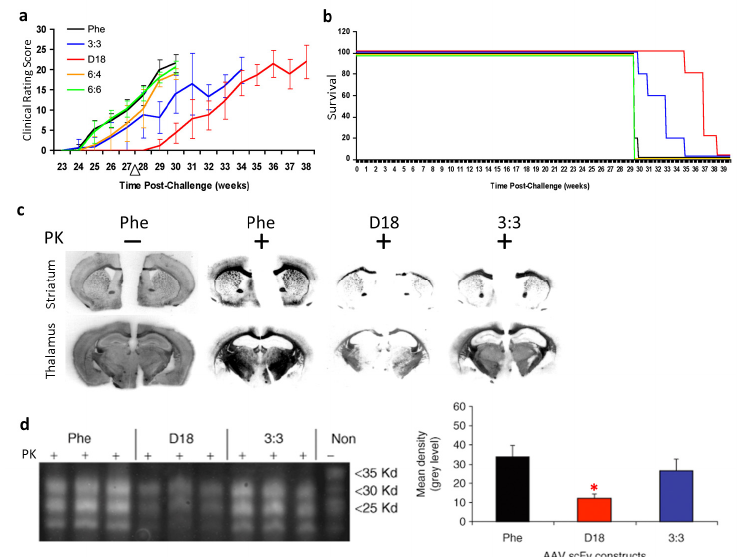
Figure 3. Outcomes of recombinant adeno-associated virus (rAAV) delivered single-chain fragment variable (scFv) therapy for prion disease in transmissible spongiform encephalopathies (TSE) mouse model. ( a ) Clinical rating data show that the disease onset was delayed in mice administered rAAV2-scFvD18; ( b ) Gehan-Wilcoxon test data show that the incubation period of prion disease was delayed in mice treated with scFv3:3 and scFvD18; ( c ) Histoblot analyses of brain sections show decreased levels of proteinase K-resistant PrP sc in scFvD18 and scFv3:3 treated mice; ( d ) Immunoblots of brain homogenates (left panel) show a decreased level of proteinase K-resistant PrP sc in scFvD18 and scFv3:3 treated mice. Quantitative measurements (right panel) of the immunoblots indicate that the decrease in scFvD18 group is significant when compared with the Phe control (marked with “*”, p < 0.004, t -test). PK: proteinase K; “ − ”: no PK digestion; “+”: PK digested. Figures reproduced from Wuertzer et al. , 2008